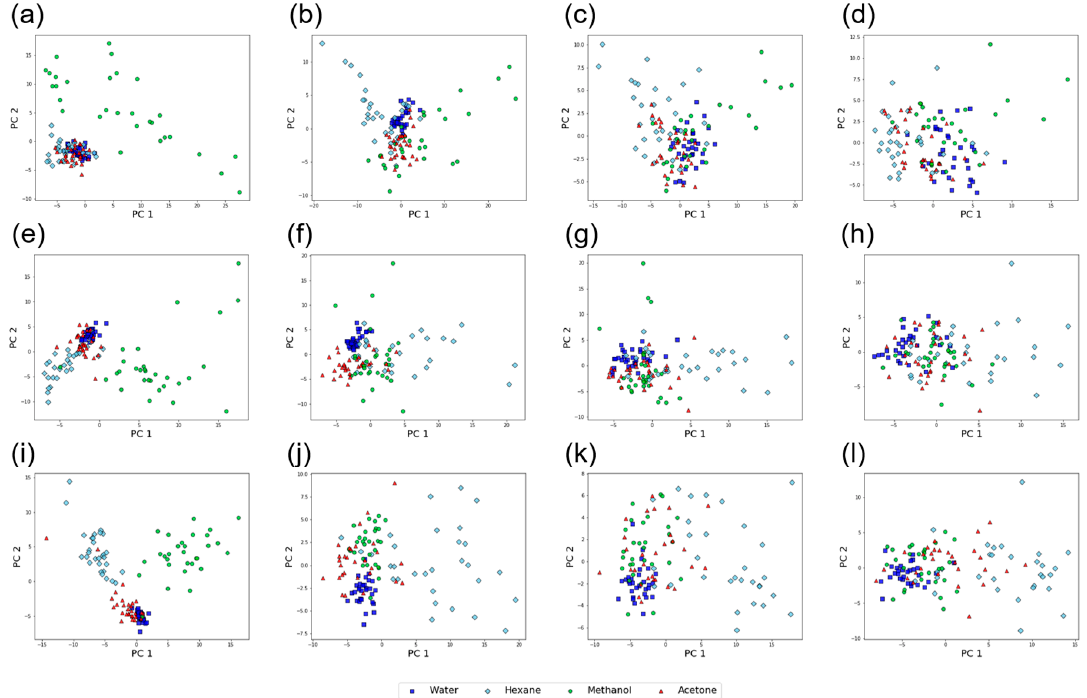
Figure 7. PCA score plots for TFRs datasets. ( a )–( d ) Data I, Data II, Data III, and Data IV from the TFRs datasets obtained by Protocol-1; ( e )–( h ) Data I, Data II, Data III, and Data IV from the TFRs datasets obtained by Protocol-3; ( i )–( l ) Data I, Data II, Data III, and Data IV from the TFRs datasets